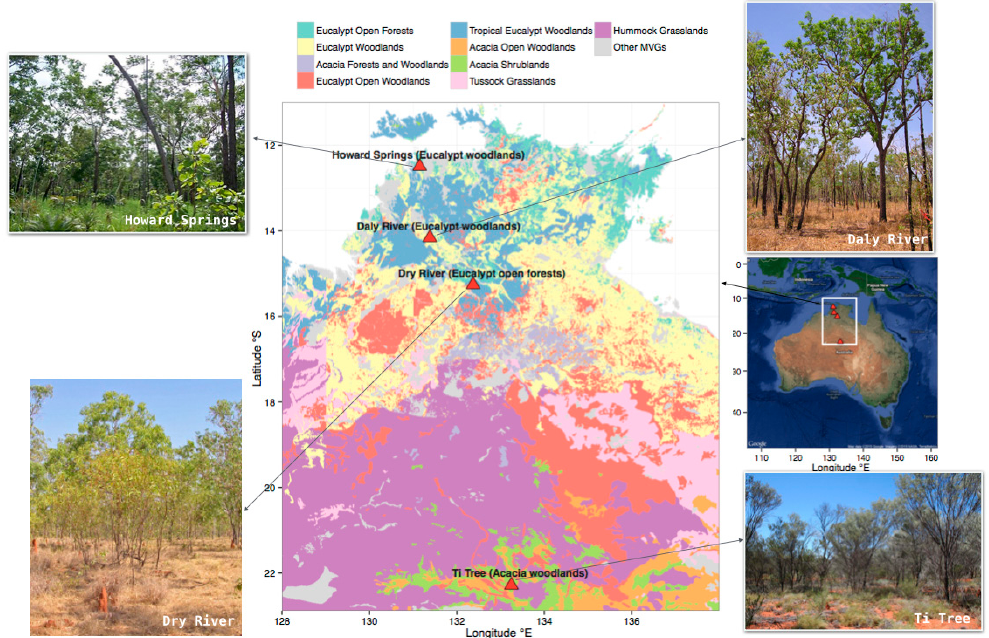
Figure 1. Spatial extent of the North Australian Tropical Transect (NATT) study area. The red triangles indicate the locations of the four local sites. Background is the map of the Australian Major Vegetation Groups (MVGs, V4.1), provided by the Australian National Vegetation Information System. Central-right panel shows the locations of the study area over the Australian continent (image source: Google Earth). Photographs show the ground-view of each flux tower site (image credit: www.OzFlux.com). Top-left—wet season at Howard Springs; bottom-left—dry season at Daly River; top-right—dry season at Dry River; bottom-right—woodland floor and understorey at Ti Tree.